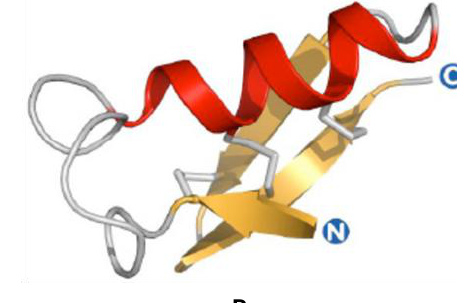
Figure 2. ( A ) Chemical structures of the methylglyoxal (MGO). ( B ) Homology model